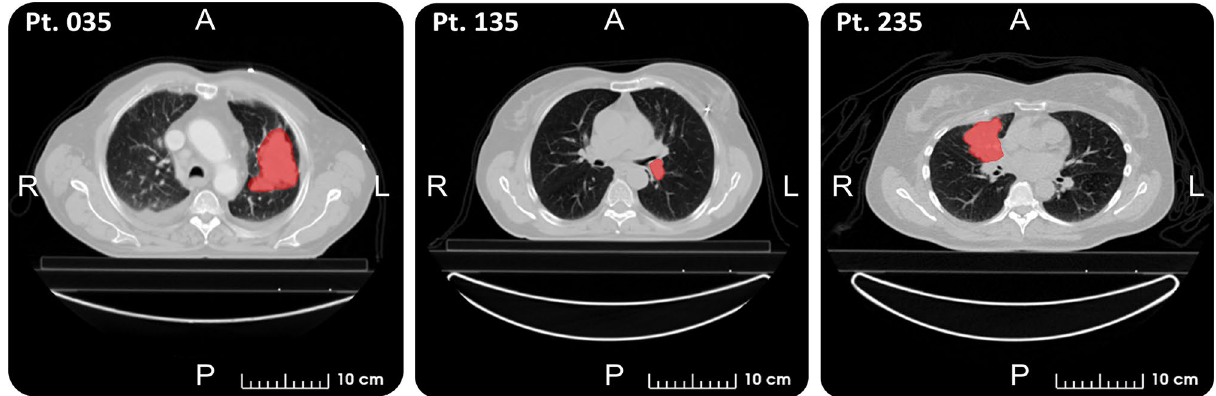
Figure 1. Representative slices of three LUNG1 patients with superimposed delineation of the GTV (viewing window: [−1000, 400] HU).